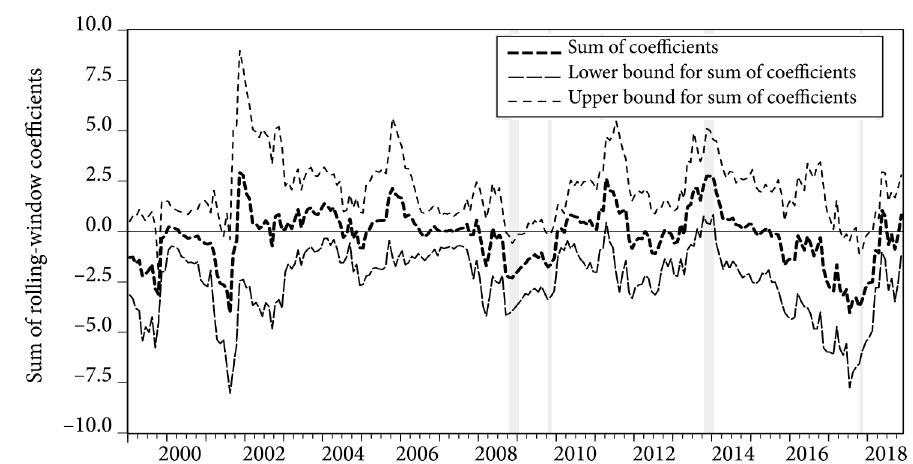
Figure 4. Bootstrap estimates of the sum of the rolling-window coefficients for the impact of GP on